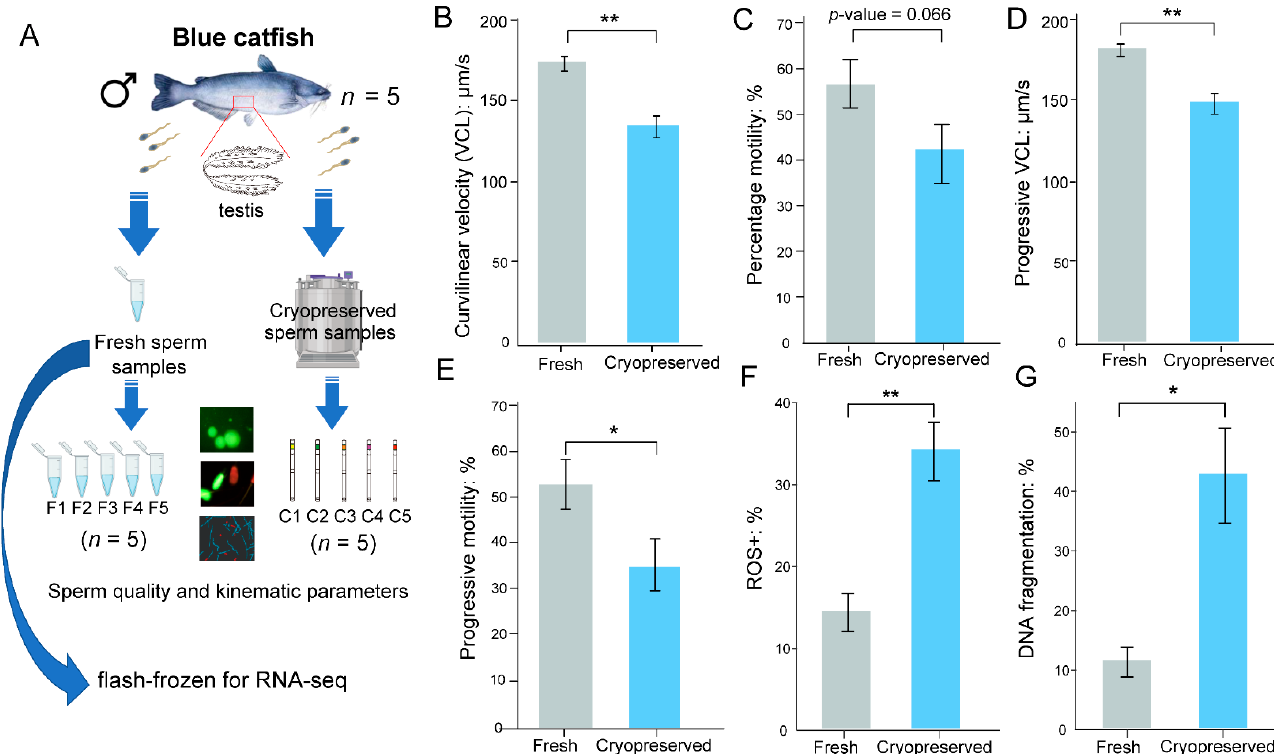
Figure 1. Blue catfish sperm quality metrics before and after cryopreservation. ( A ) Experimental design and procedure for comparing fresh (F) vs. cryopreserved (C) sperm quality. Various quality metrics were measured in fresh and cryopreserved sperm: curvilinear velocity (VCL) of motile sperm ( B ); percent motility ( C ), progressive VCL ( D ), progressive motility ( E ), oxidative stress level measured by percent of ROS+ ( F ), and DNA fragmentation ( G ). Statistical significance was determined by Student’s paired t-test (* p < 0.05; ** p < 0.01).